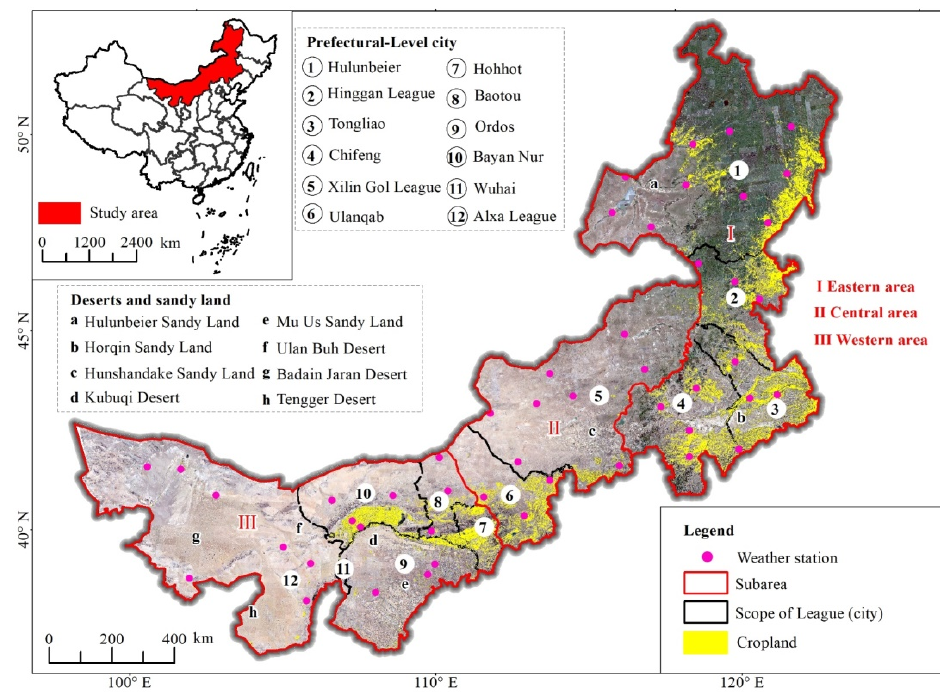
Figure 1. The location and cropland distribution of Inner Mongolia, China.